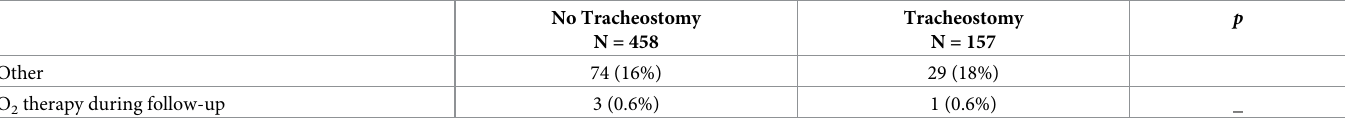
GCS: Glasgow Coma Score. COPD: Chronic Obstructive Pulmonary Disease. MV: Mechanical Ventilation. Numeric data are analysed with student or wilcoxon � test accordingly. Categorical data are analysed with Chi2 test or Fisher test £ accordingly.